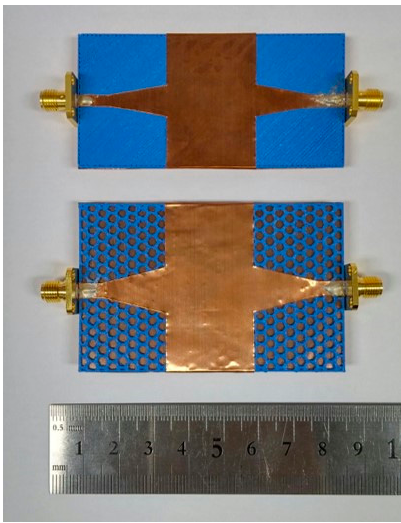
Figure 10. Fabricated 3D ‐ printed microstrip ‐ fed SIW with solid PLA and honeycomb substrate.